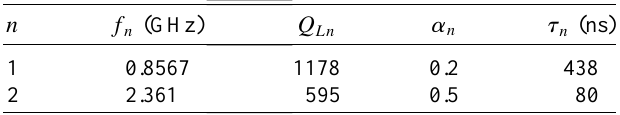
TABLE I. Loaded Q ’s, coupling factors, and decay times for the two resonant frequencies.